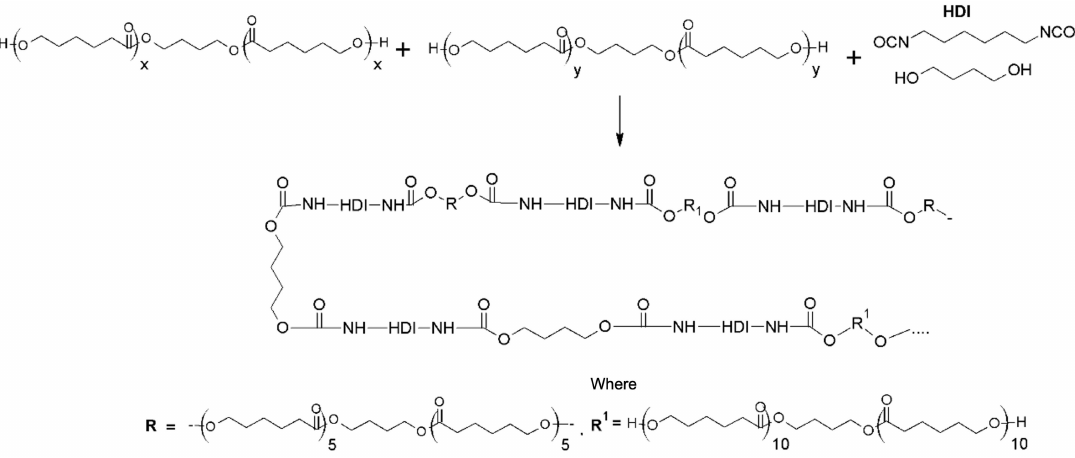
Figure 1. Reaction